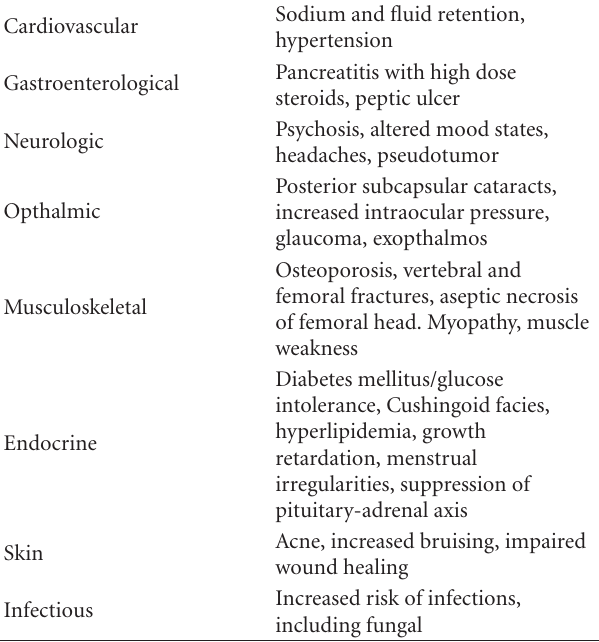
Table 2: Side e ff ects of corticosteroids.